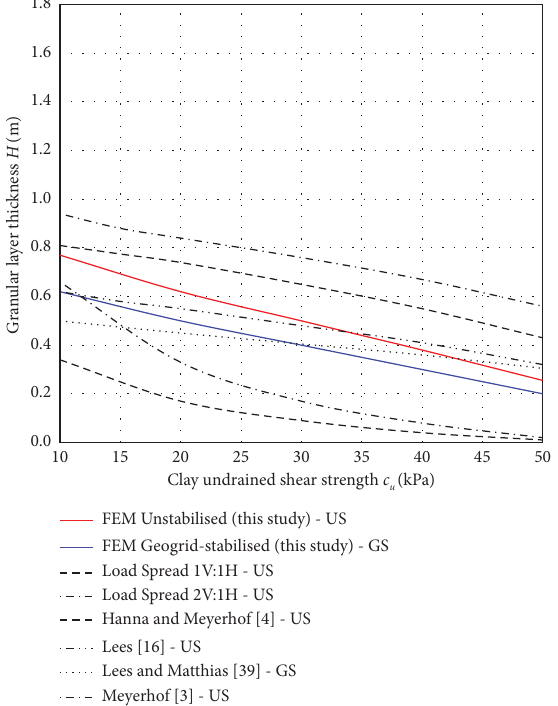
Figure 17: Granular layer thickness versus clay undrained shear strength (US: unstabilised and GS: